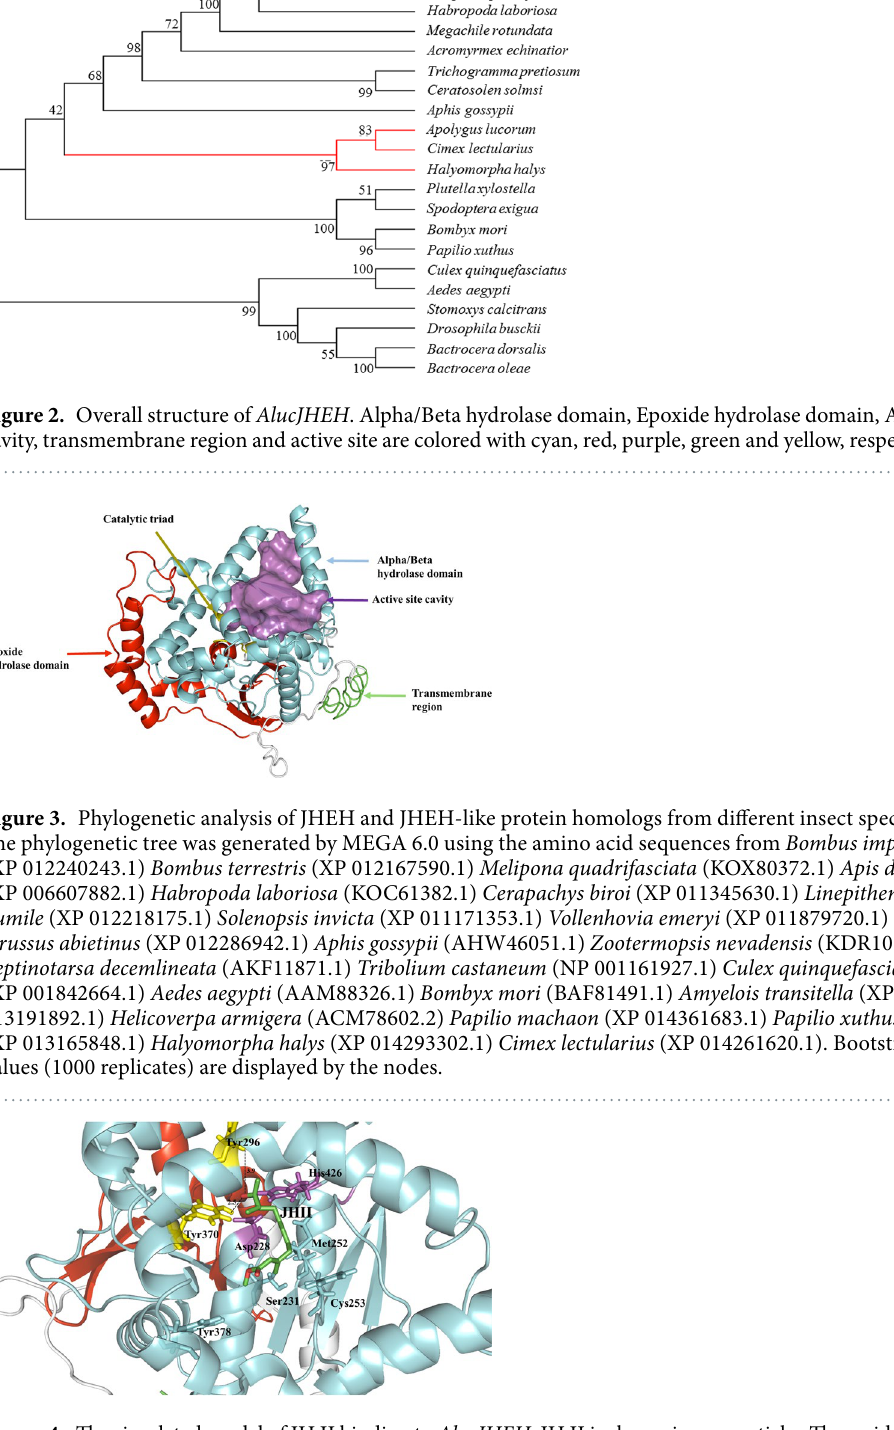
Figure 4. The simulated model of JH II binding to AlucJHEH . JH II is shown in green sticks. The residues that binding to the JH II are labeled and shown as